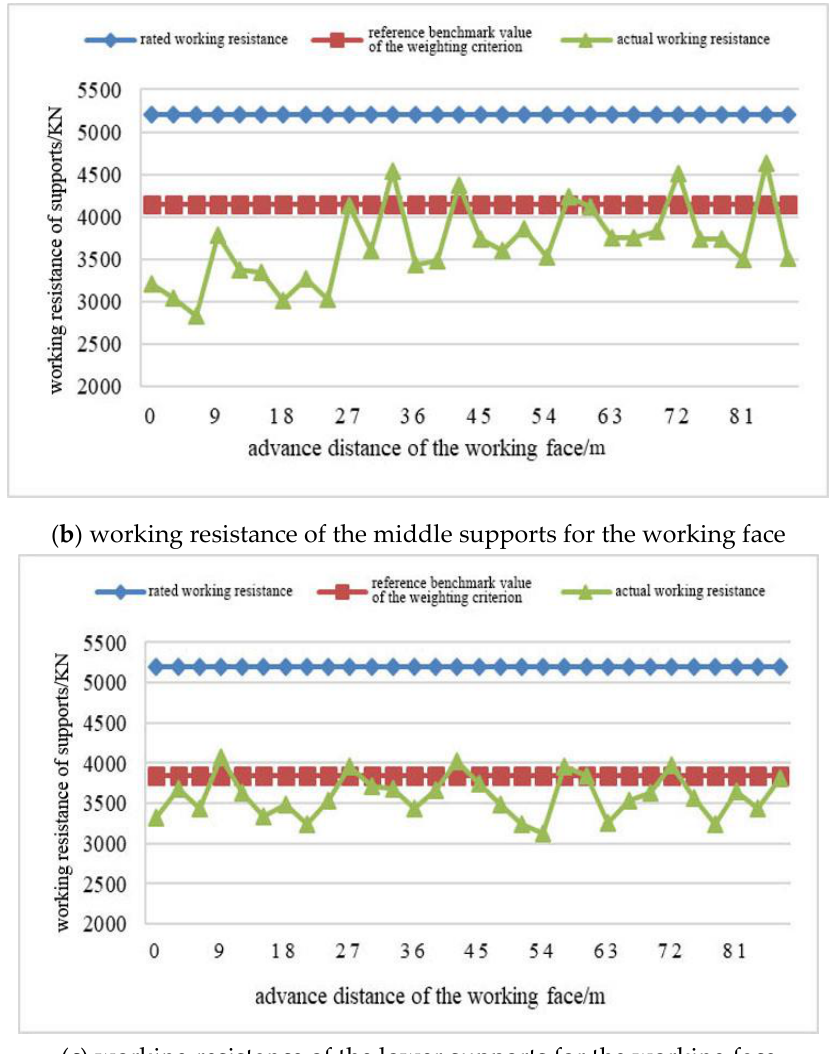
Figure 10. Working resistance of supports for the working face under different mining degrees.